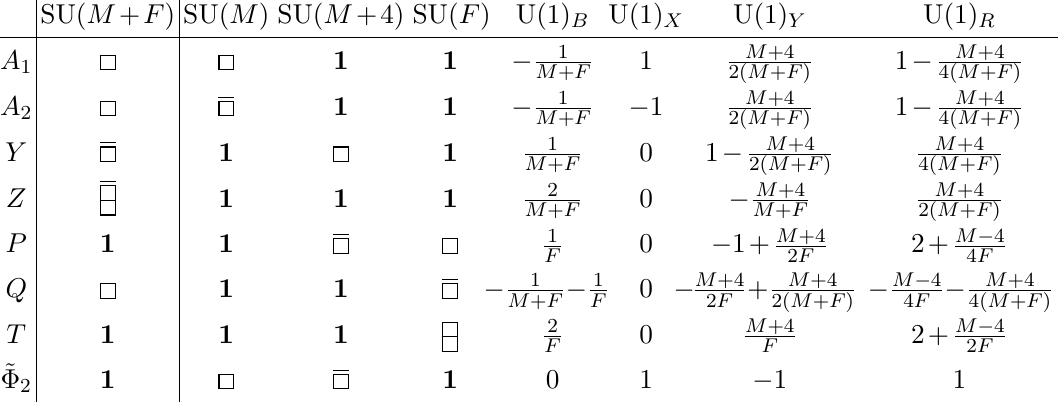
Table 3. The charge table for Q A , which can be obtained from table 1 by adding the elementary SO meson ˜Φ 2 (flipping Φ 2 = A 2 Y ). (Similarly, the charge table for Q B can be obtained from table 2 USp by removing the elementary meson Φ 2 .) Doing so breaks USp(2 M ) → SU( M ) × U(1) X , but leads to the accidental enhancement SU( M + 4) × U(1) Y → SO(2 M + 8) at the infrared fixed point. The (cid:0) M (cid:1) a -maximized R -charge is U(1) sc = U(1) R + x M U(1) X − x 2 + 1 U(1) B where x M is the middle R M 4 3 root of 9 Mx 3 + 9( M + 4) x 2 − 3(3 M + 8) x M − ( M + 4) = 0 , varying between x 0 ’ − 0 . 1381 and M M x ∞ ’ − 0 . 1018